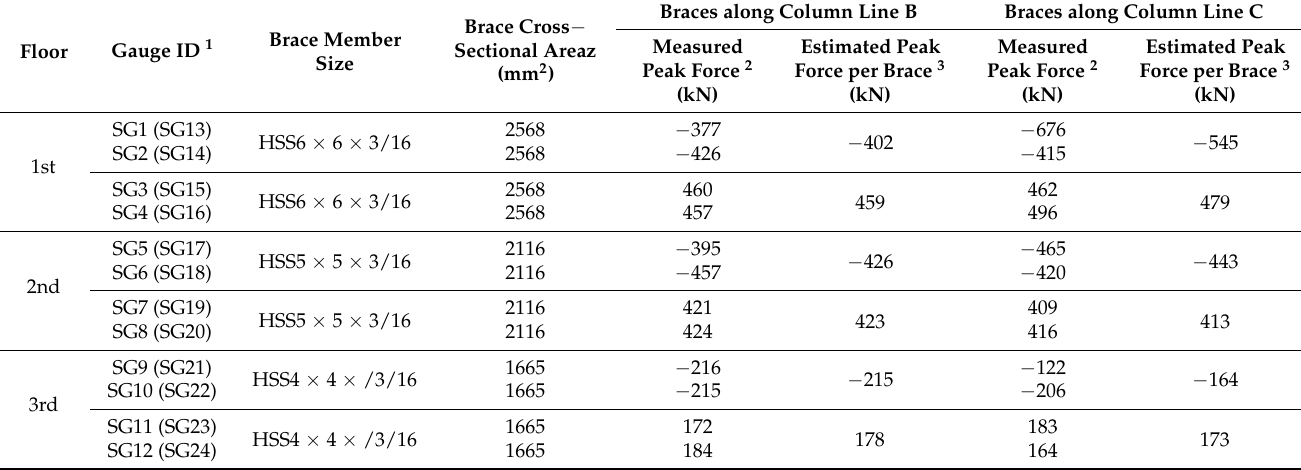
1 IDs within brackets are strain gauges on column line C braces. 2 Taken at the peak measured strain multiplied by steel elastic modulus (200 GPa) and by brace cross-sectional area. 3 Taken as the average of the measured peak force from the two strain gauges at each brace